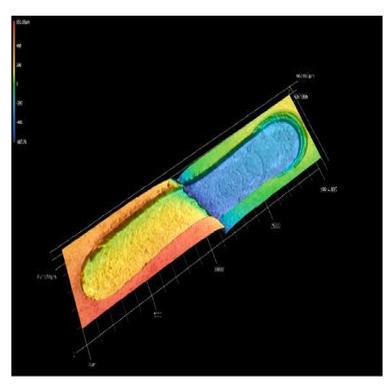
Tensile samples madea. out of sample A.